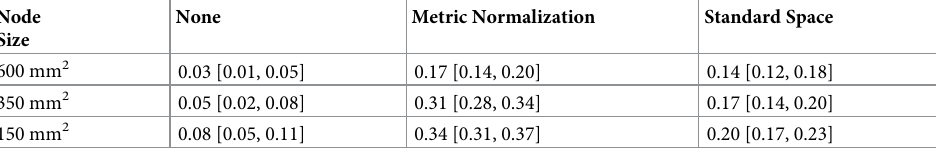
Table 4. Fractional variation explained [95% confidence limits] of the machine learning algorithm for predicting patient IQ based on network